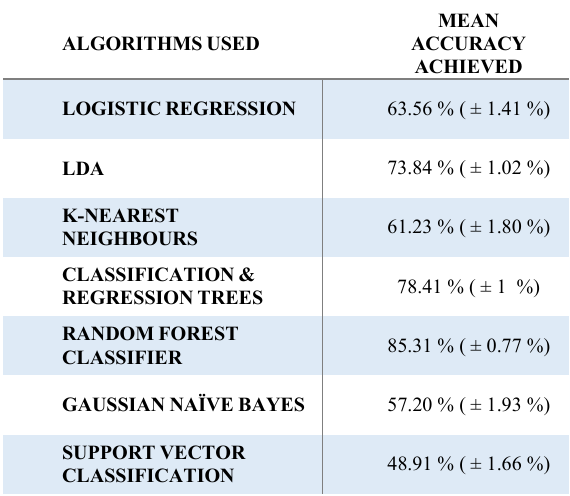
Table 1. Comparative Analysis of various machine learning algorithms